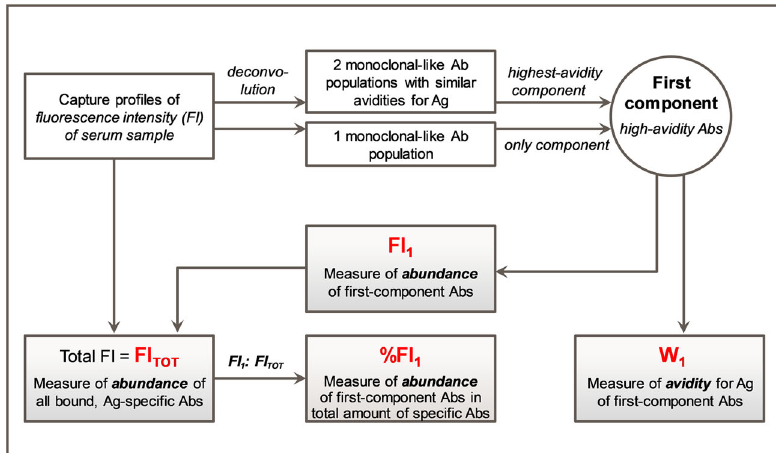
Fig. 3 Summary of the data analysis strategy and main parameters. Figure summarizes the data analysis pipeline applied to characterize the avidity of polyclonal antibody (Ab) populations in sera obtained after vaccination (see Suppl. Fig. 5 and “ Methods ” section for details). Fluorescence intensity (FI) data representing the antigen (Ag)-Ab binding (antibody ‘ capture pro fi les ’ ) were obtained by micro fl uidic ligand- binding immunoassay. The area under the capture pro fi le represented the total amount of HBsAg-speci fi c antibodies in the sample (FI TOT ). Modeling of the capture pro fi les using a deconvolution algorithm-generated one or two monoclonal-like Ab populations with similar avidities ( ‘ components ’ ). Abs in the highest-avidity ( ‘ fi rst ’ ) component is characterized by %FI 1 (FI contribution from these Abs [FI 1 ] relative to the FI TOT ), and the avidity score W 1 representing the binding strength of these Abs. Parameters indicated in red font were used to characterize the abundance and avidity of the sera. The cutoff for high-avidity Abs was de fi ned as W 1 < 5, corresponding to approximately K D < 10 − 10